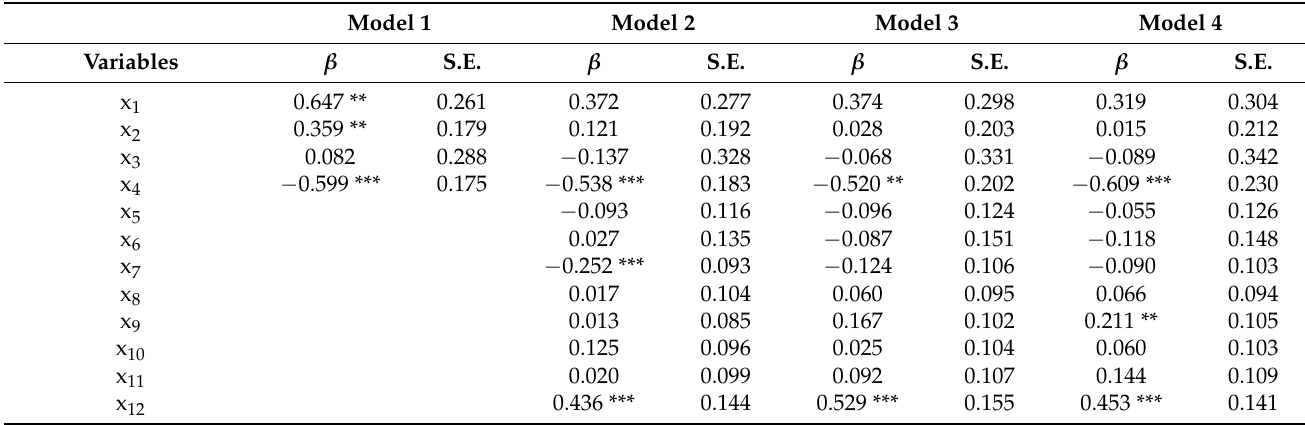
Table 8. Logistic regression for new-to-the-market process innovation (y 2